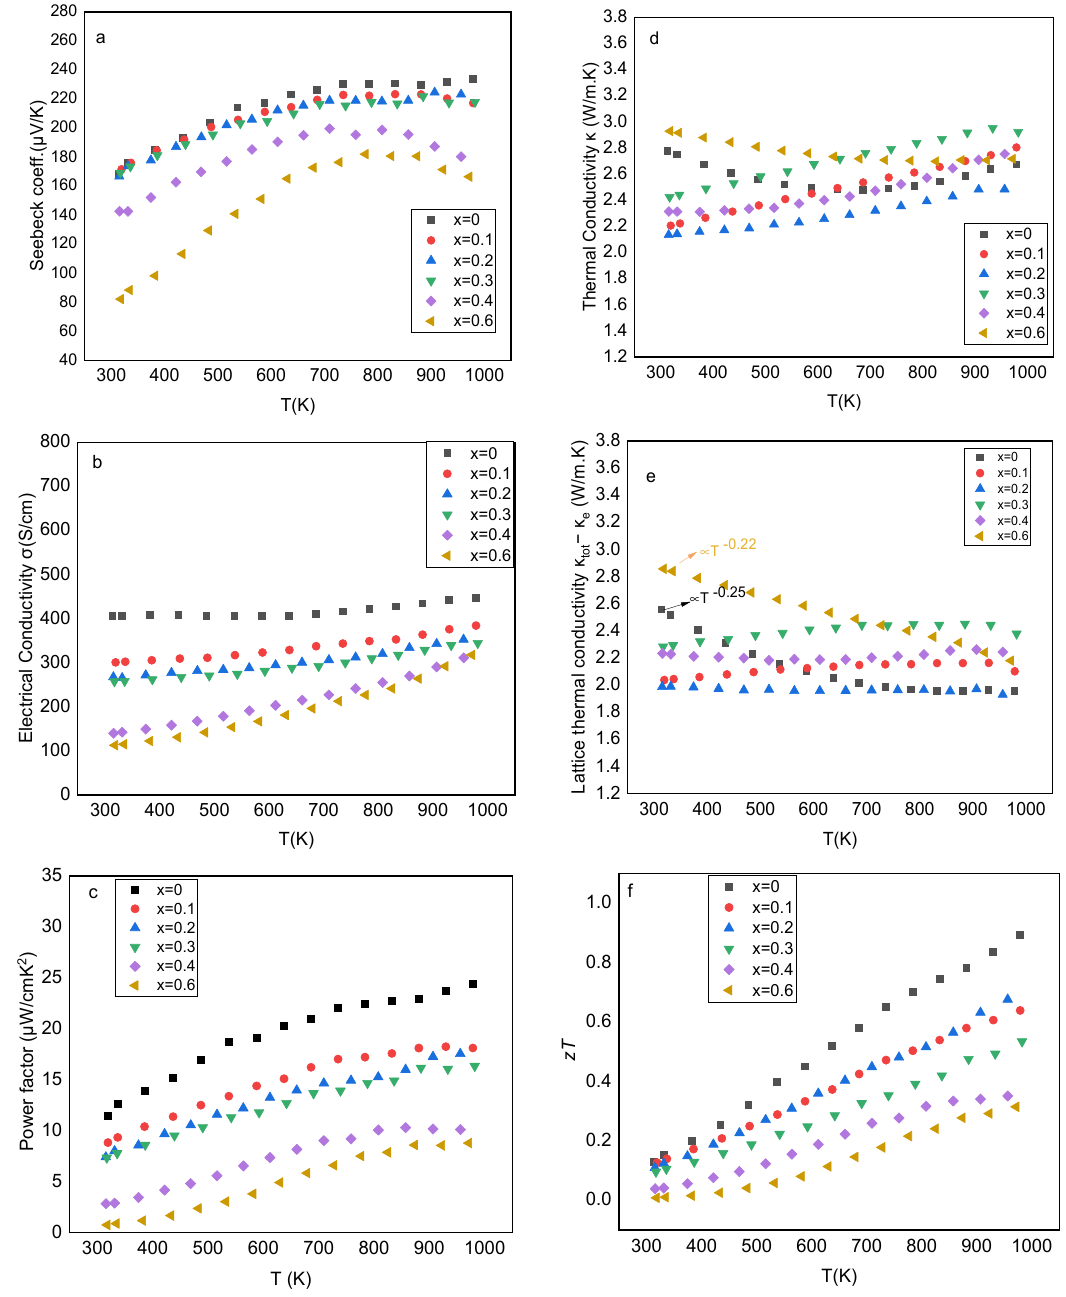
Figure 4. Temperature-dependent Seebeck coefficient ( a ), electrical conductivity ( b ), Power factor ( c ), total thermal conductivity ( d ), lattice thermal conductivity ( e ) and thermoelectric figure-of-merit zT ( f ) of Hf 0.6-x Zr x Ti 0.4 CoSb 0.8 Sn 0.2 samples. The temperature dependence of total thermal conductivity ( κ ) and lattice thermal conductivity ( κ lattice ) of Hf 0.6-x Zr x Ti 0.4 CoSb 0.8 Sn 0.2 samples are presented in Figure 4d,e, while the lattice thermal conductivity at room temperature as a function of Zr concentration (x) is presented in Figure 5a. At room temperature, samples with x = 0 and x = 0.6 present the highest thermal conductivity values ( κ = 2.8 W/m · K and κ = 3.0 W/m · K respectively). On the other hand, samples with x = 0.1–0.4 present lower thermal conductivity at room temperature (in the range of 2.4–2.15 W/m · K) but then slightly increases with the